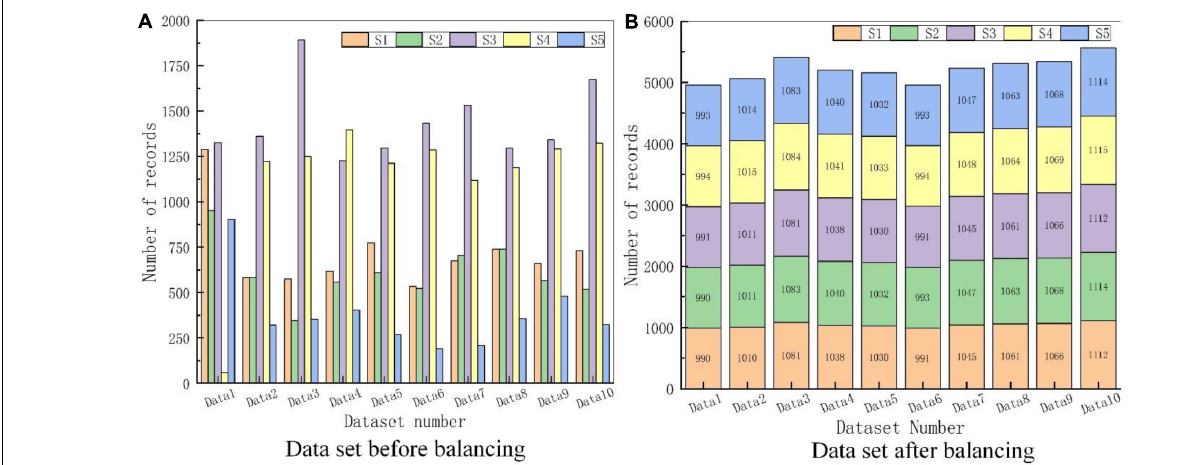
FIGURE 3 | Data set before balancing (A) , Data set after balancing (B) .